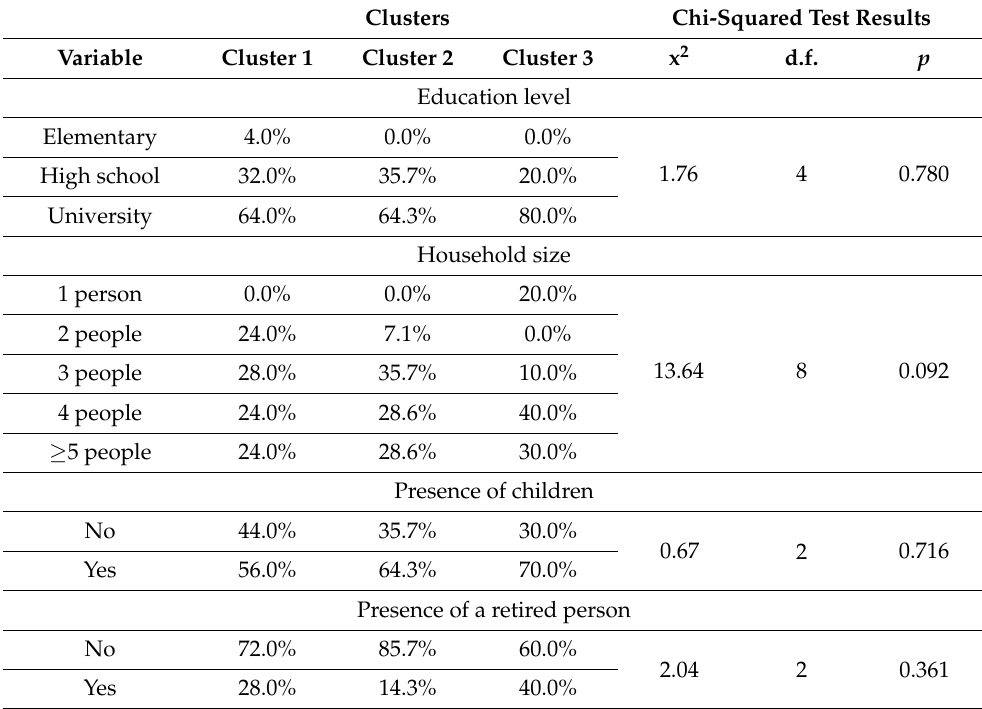
Table 6. Chi-squared analysis of socio-demographic variables between clusters in summer.